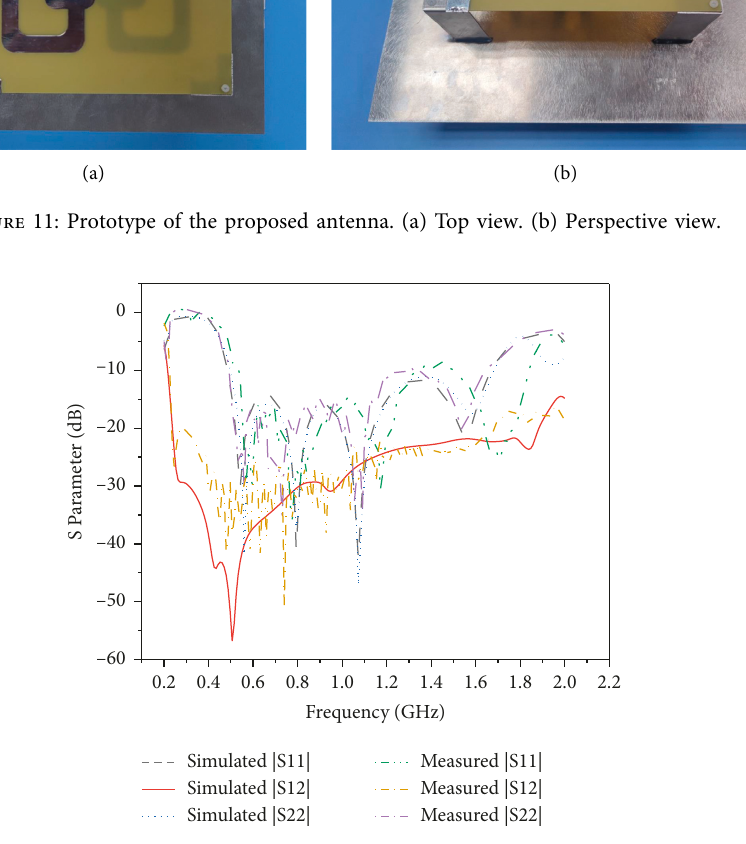
Figure 12: Simulated and measured S-parameters of the proposed antenna.